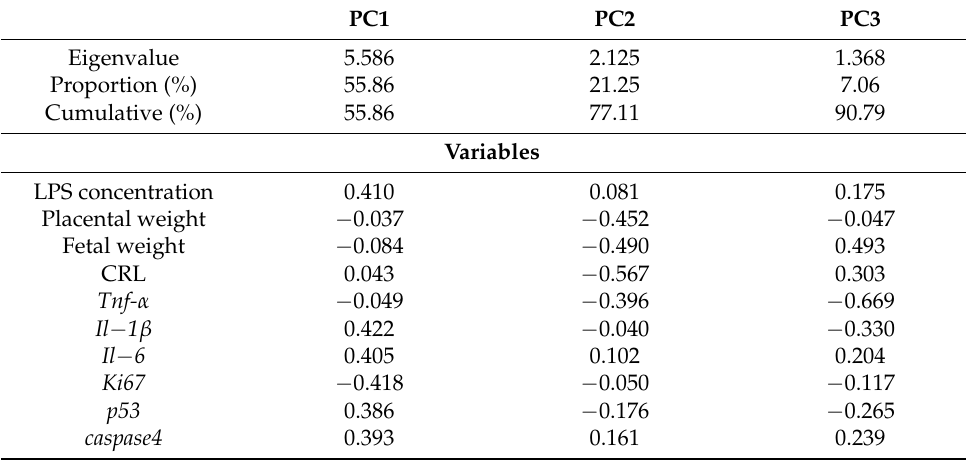
Table 3. Proportion and variables of the three principal components (90.79%).